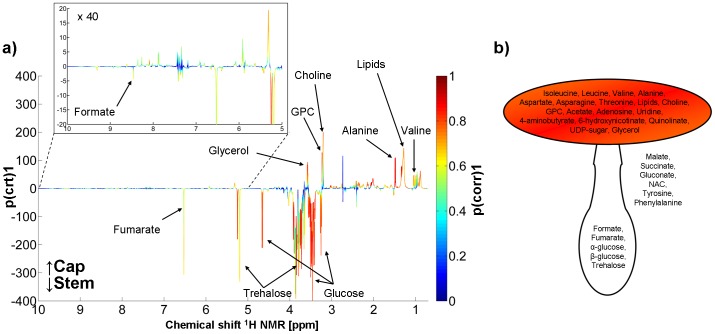
Distribution of metabolites in A. muscaria basidocarps: a) loadings of discrimination between stems and caps from the OPLS-DA model.The color bar corresponds to the absolute value of the correlation loading; b) simplified representation of metabolite distributions in A. muscaria basidocarps.